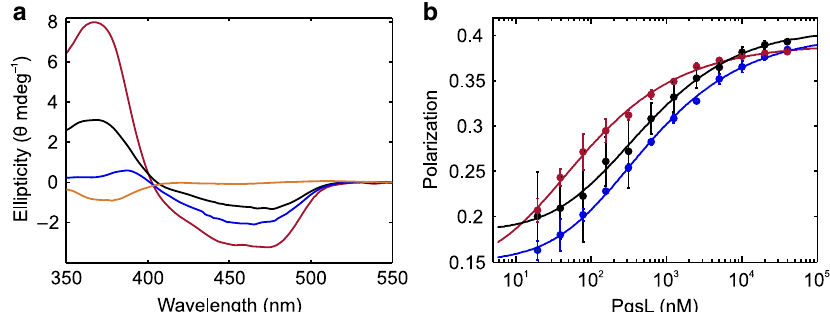
Fig. 4 Spectroscopic assessment of fl avin conformation and FAD-binding equilibria in PqsL. a Circular dichroism spectra of FAD in solution (orange), PqsL (black), PqsL + 2-ABA (blue) and PqsL-Q (red) (one representative measurement). b Dilution series of PqsL, monitored by FAD fl uorescence polarization, to deduce K D of PqsL- (black), PqsL-2ABA- (blue), and PqsL-Q- (red) complexes with FAD (error bars indicate SD from three independent experiments). K D values were 249.5 ± 29.8 nM for the PqsL-, 259.8 ± 19.2 nM for PqsL-2ABA- and 37.5 ± 6.7 nM for the PqsL-Q-FAD